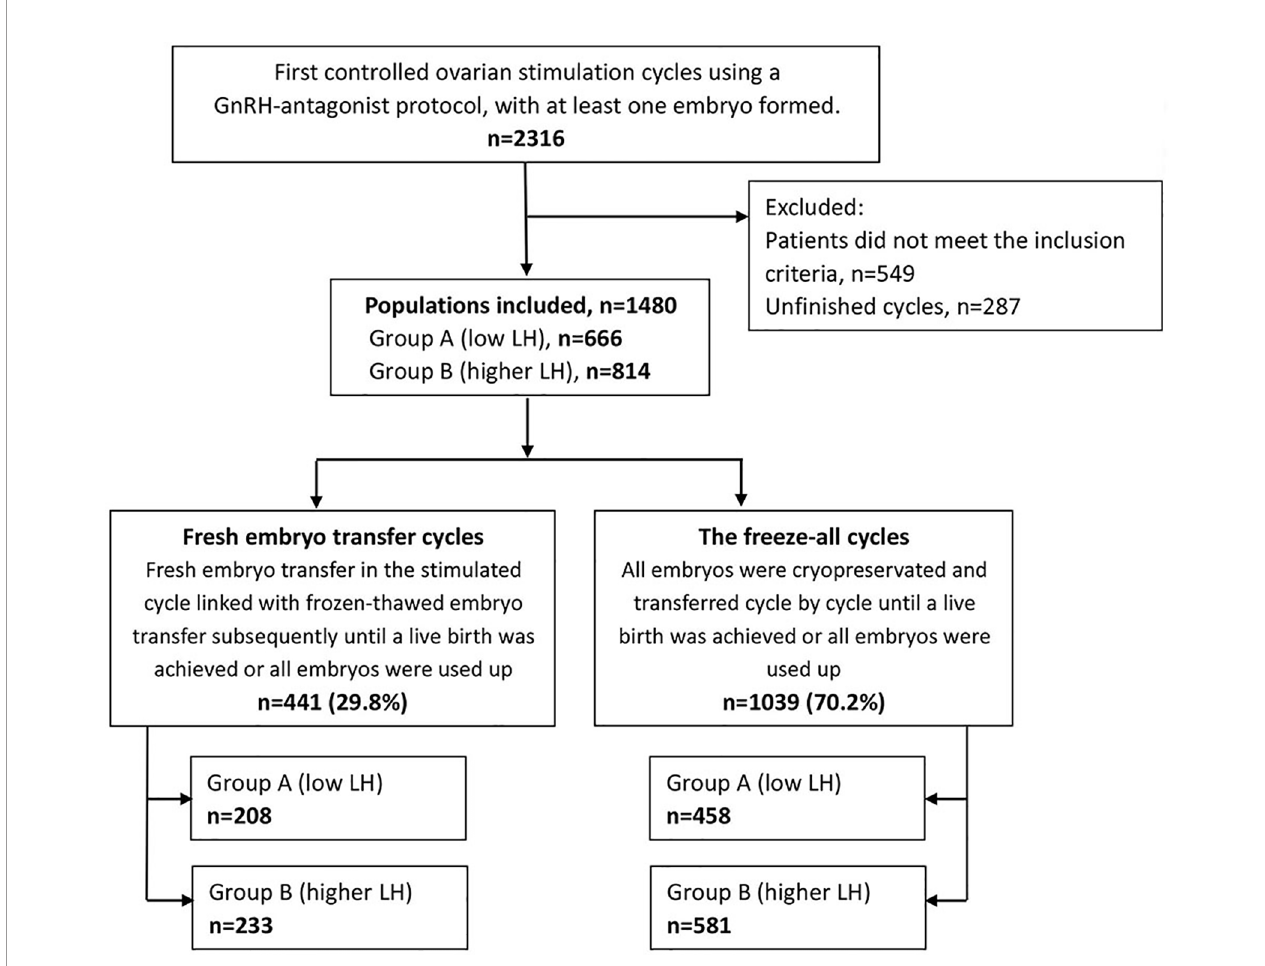
FIGURE 1 | Flow chart and group division of this